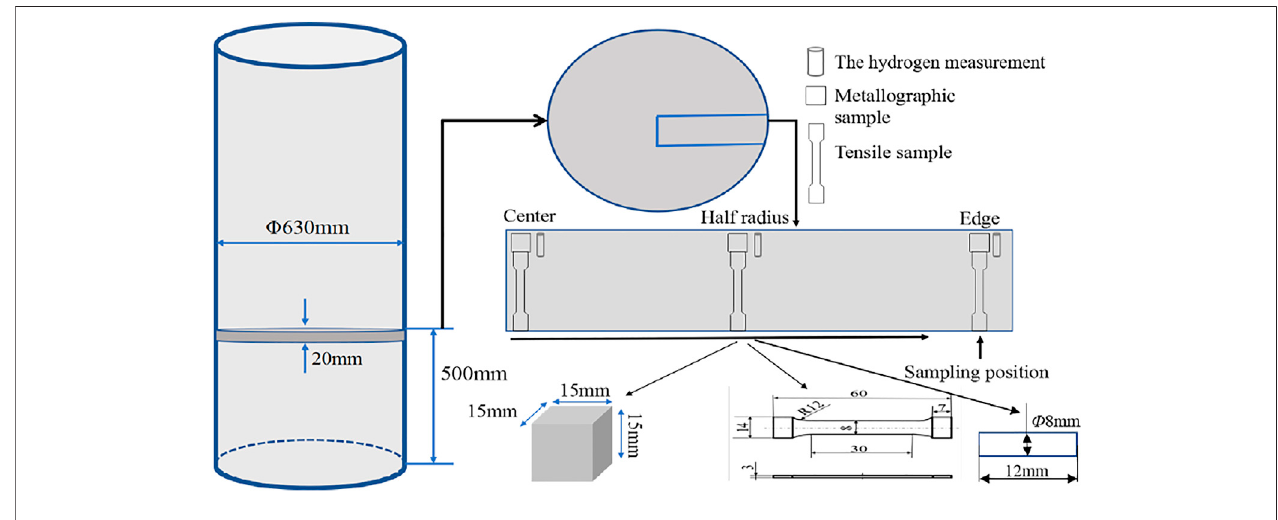
FIGURE 2 | Dimensions and sampling locations of the two ingots.